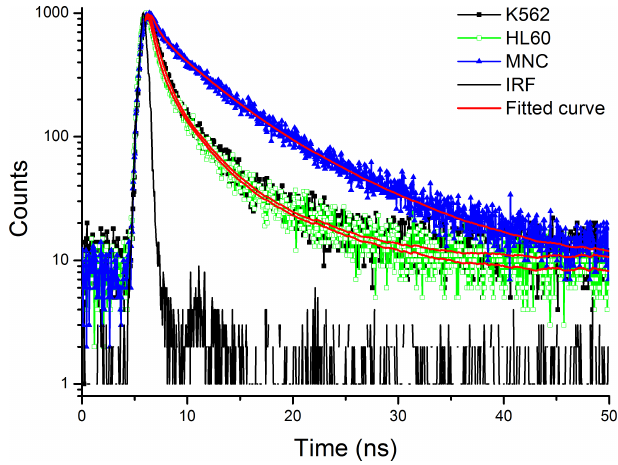
Fig. 2. Time-resolved auto°uorescence spectra of K562, HL60 cells, and MNC ( (cid:4) ex ¼ 405 nm and (cid:4) em ¼ 455 nm).